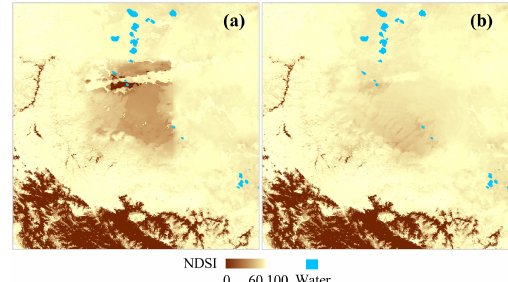
Figure A2. Post-processing over Taklimakan Desert on 19 Jan- uary 2008. STAR result (a) . Final result (b) .